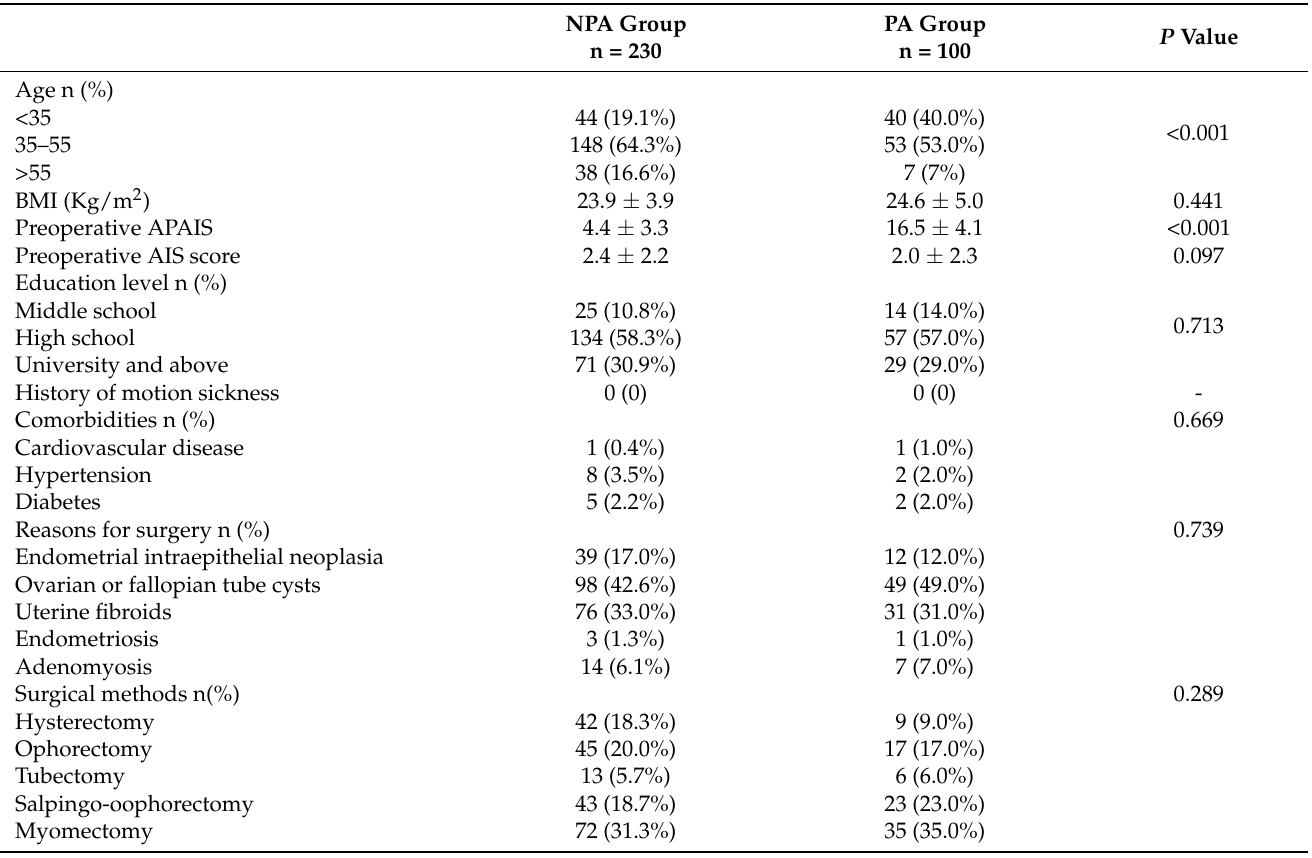
Table 1. Demographic information and intraoperative